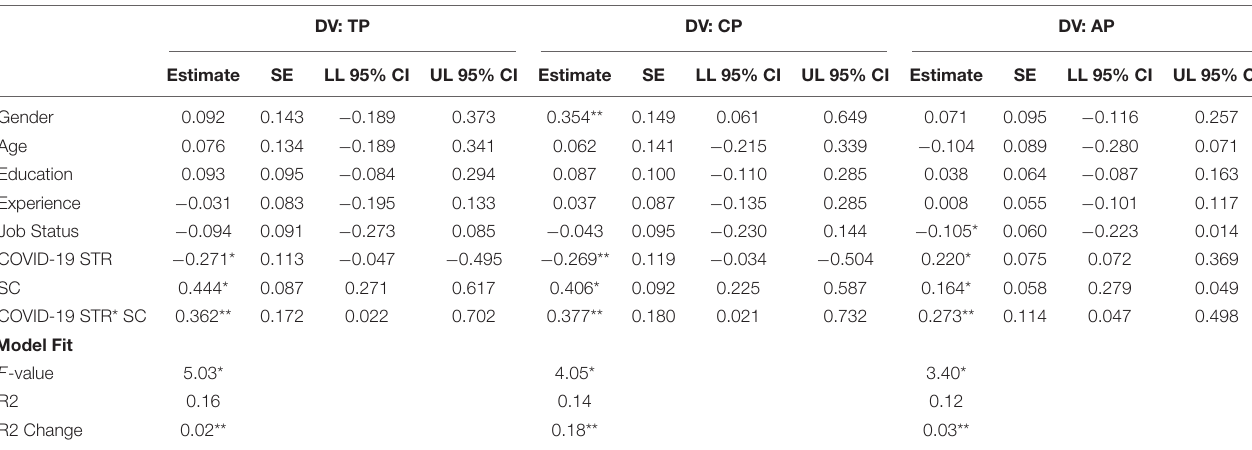
TABLE 5 | Five thousand bootstrap results for process model no.1 simple moderation